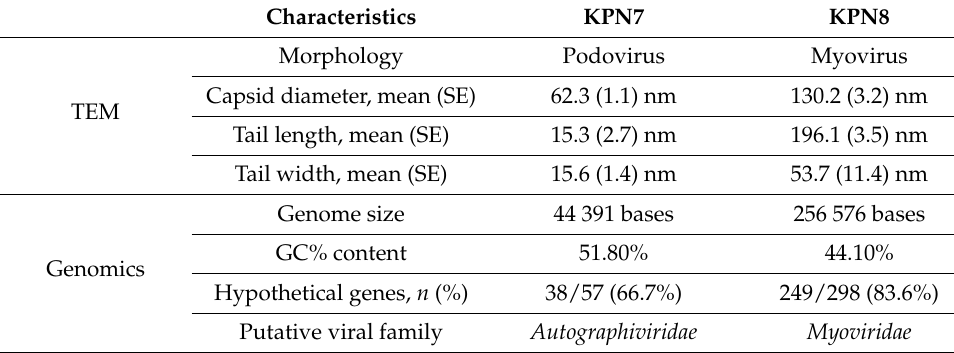
Table 1. KPN7 and KPN8 morphological and genomic